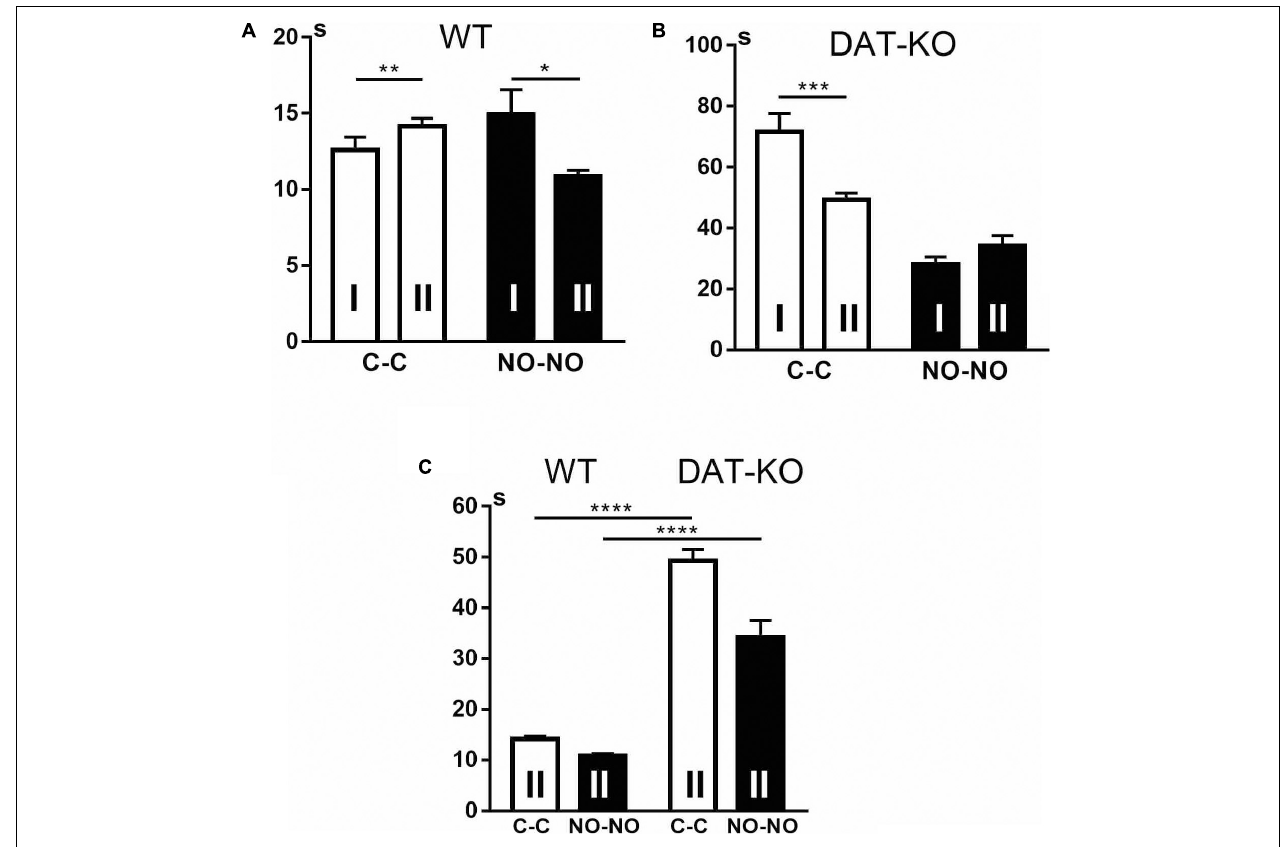
FIGURE 5 | Comparison of task fulfillment duration in WT (A,C) and DAT-KO rats (B,C) during the first (I) and second (II) blocks of experiments. White columns, cube presentation (C-C); black columns, novel object presentation (NO-NO); * p < 0.05; ** p < 0.01; *** p < 0.001; **** p < 0.0001; one-way Kruskal–Wallis test with Dunn’s multiple-comparison post hoc test. WT, wild-type; DAT-KO, dopamine transporter knockout.